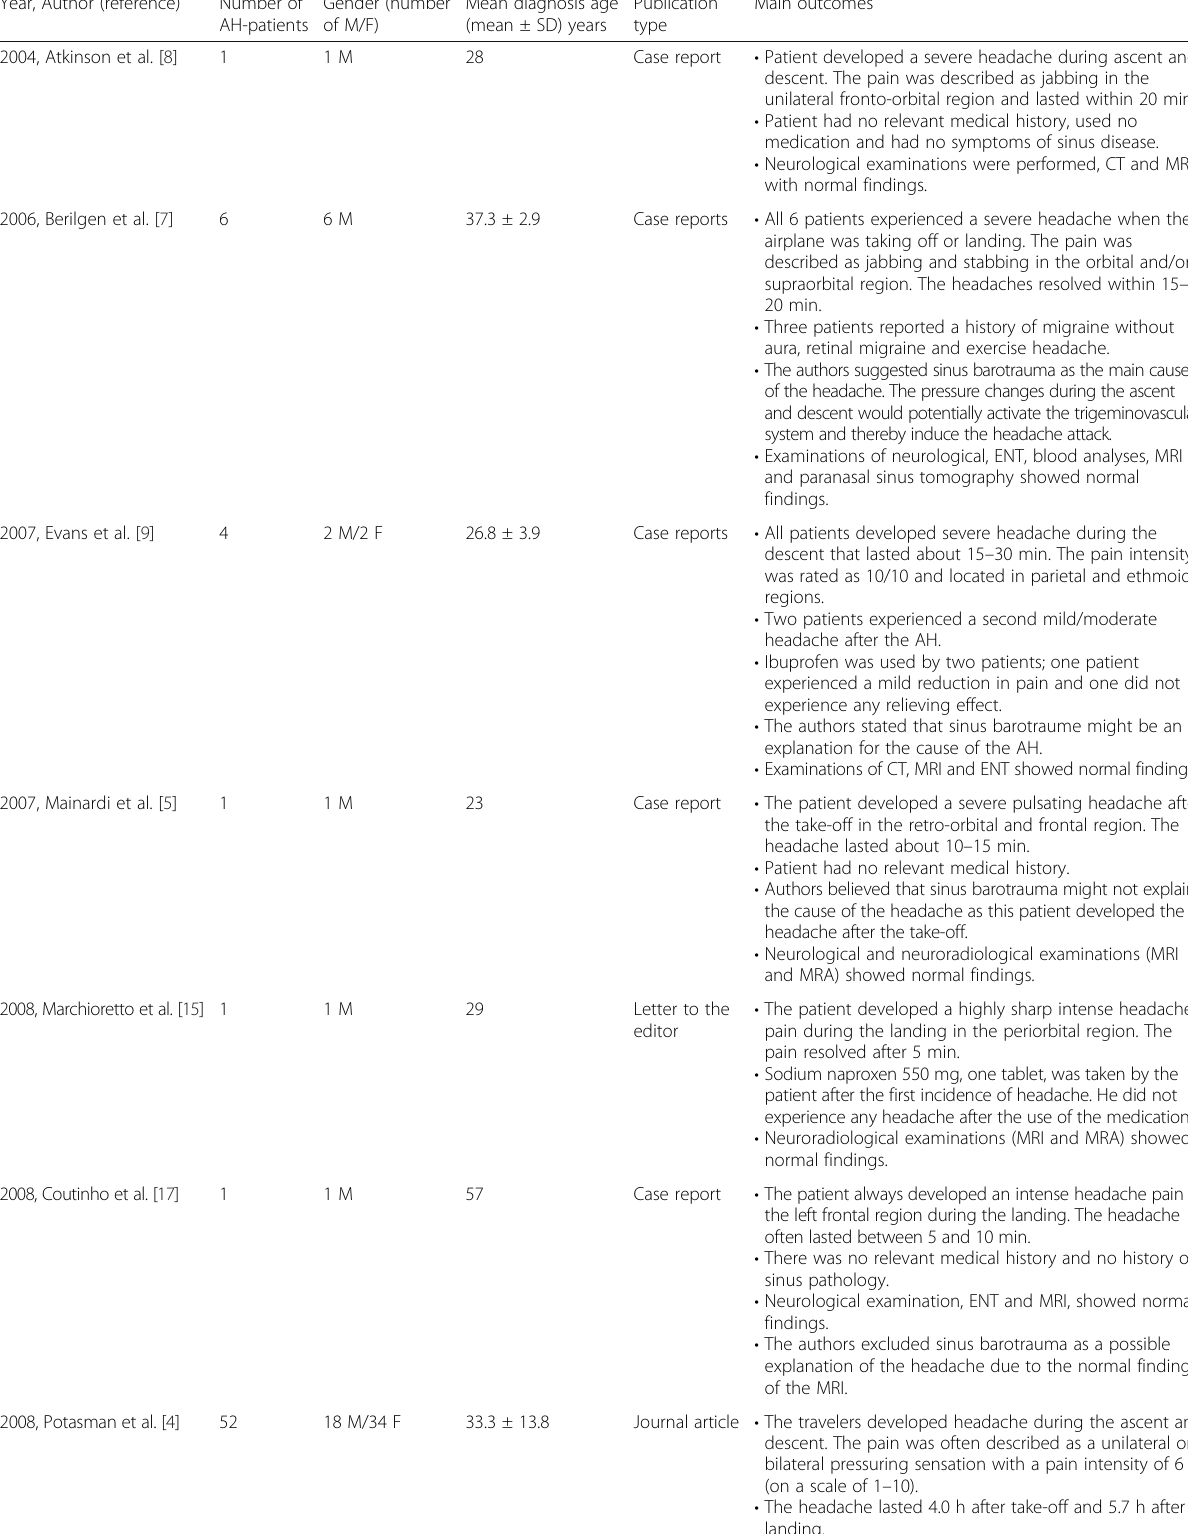
Table 1 Demographic characteristics and main outcomes of the current literature regarding headache attributed to airplane travel Year, Author